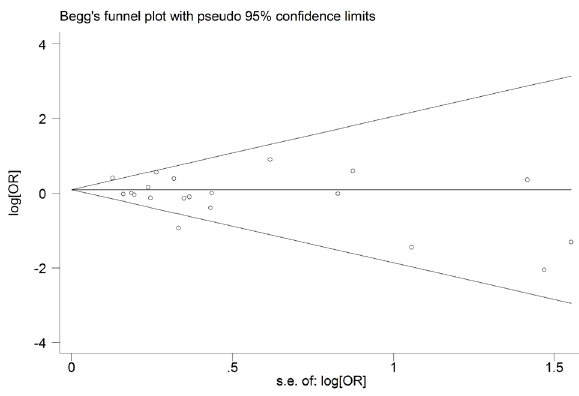
Figure 5: Funnel plot of publication biases on the associa- tion between CCR5-delta32 polymorphism and HIV-1 infection